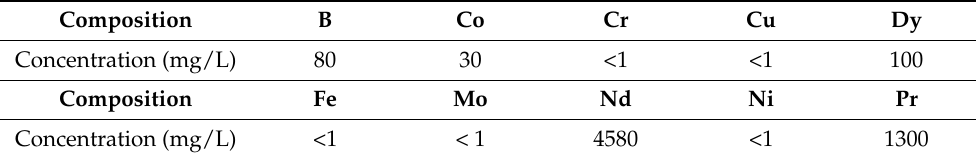
Table 4. Chemical composition of the leach liquor.